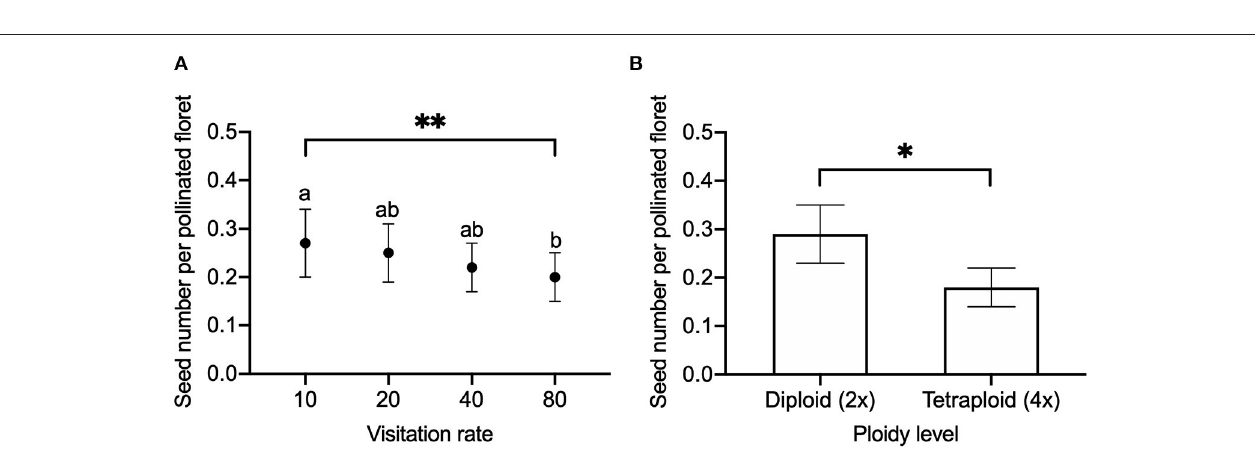
FIGURE 3 | Comparison of seed number produced per pollinated floret in red clover under (A) different visitation rates (10, 20, 40, and 80 pollinated florets per flower head) and (B) comparison between diploid and tetraploid in hand pollination. Error bars indicate the 95% confidence interval of the estimated marginal means (EMMs). EMMs sharing a lowercase letter within the same figure are not significantly different at 0.05 significance level. * P- value = 0.0170; ** P- value =